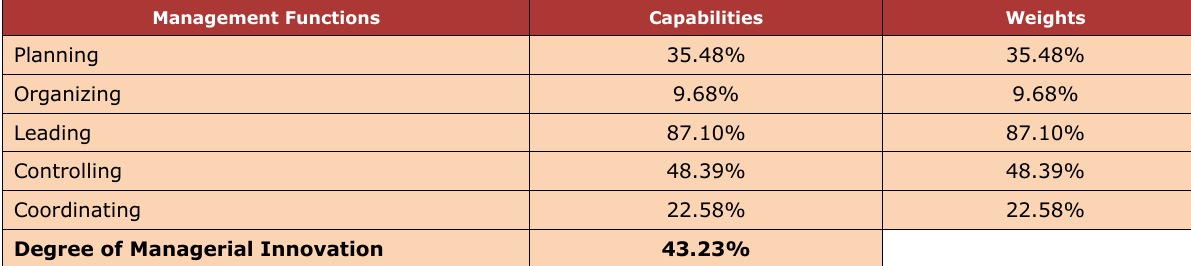
Table 2. Capabilities to follow the innovation in each function and their relative weights